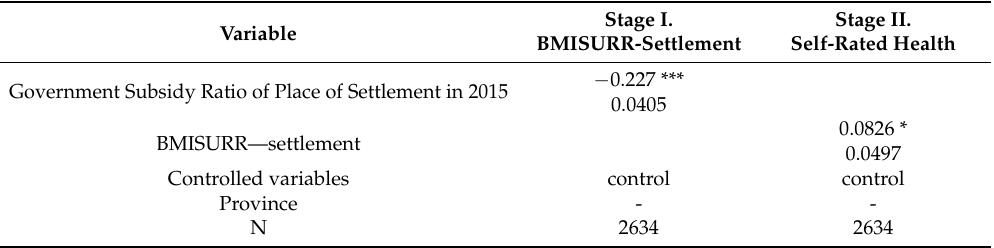
Table 6. IV Regression of place of enrollment and the health of the senior floating